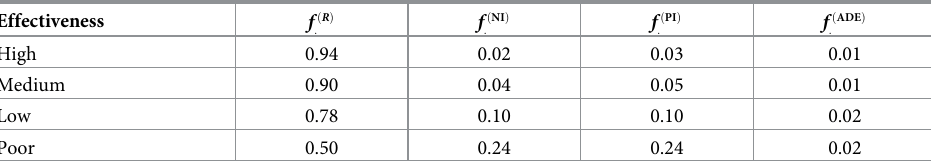
Table 1. Vaccine effectiveness.